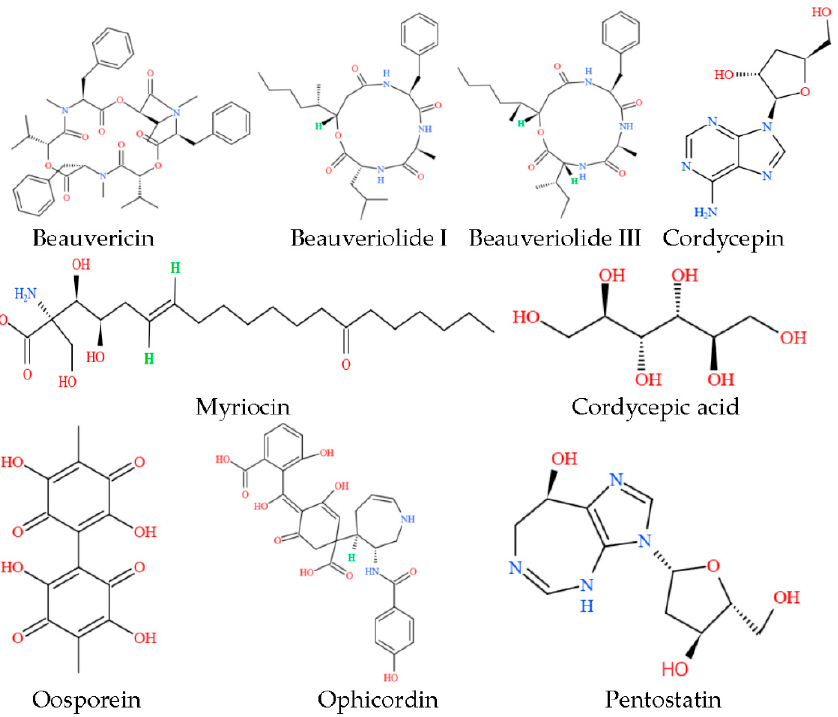
Figure 1. Structures of secondary metabolites from Cordyceps .